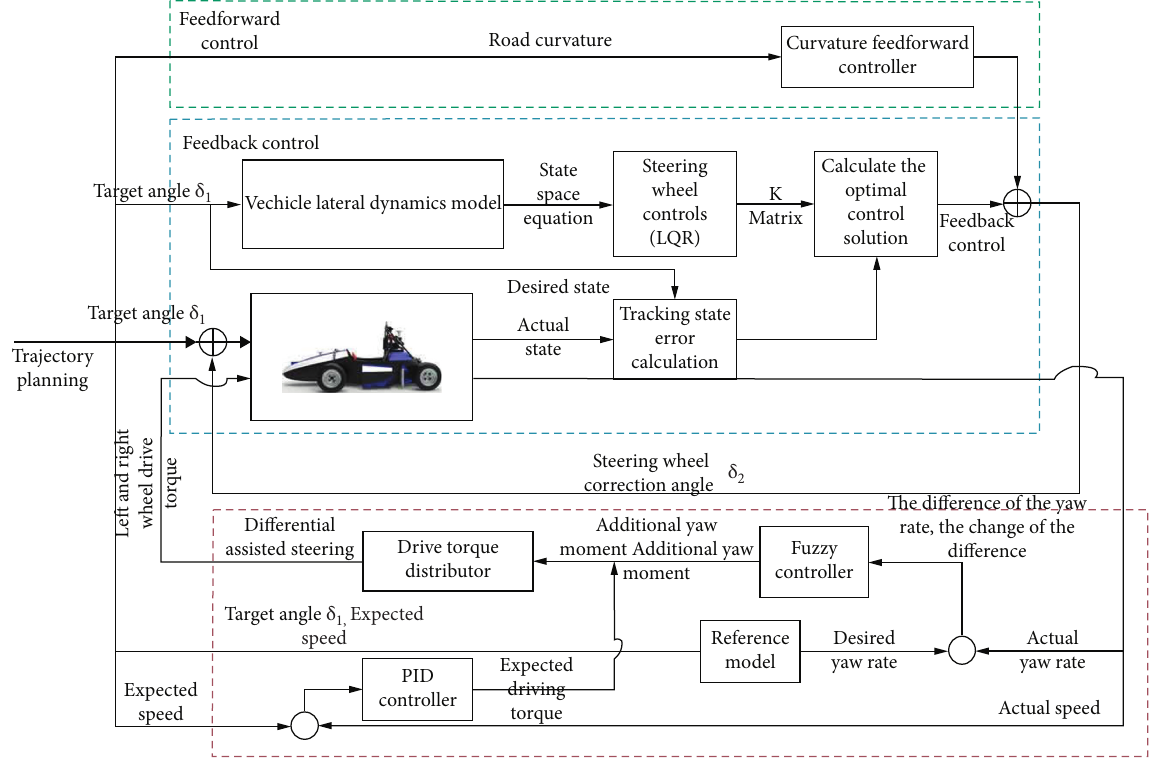
Figure 1: Integrated control strategy for trajectory tracking of driverless car.